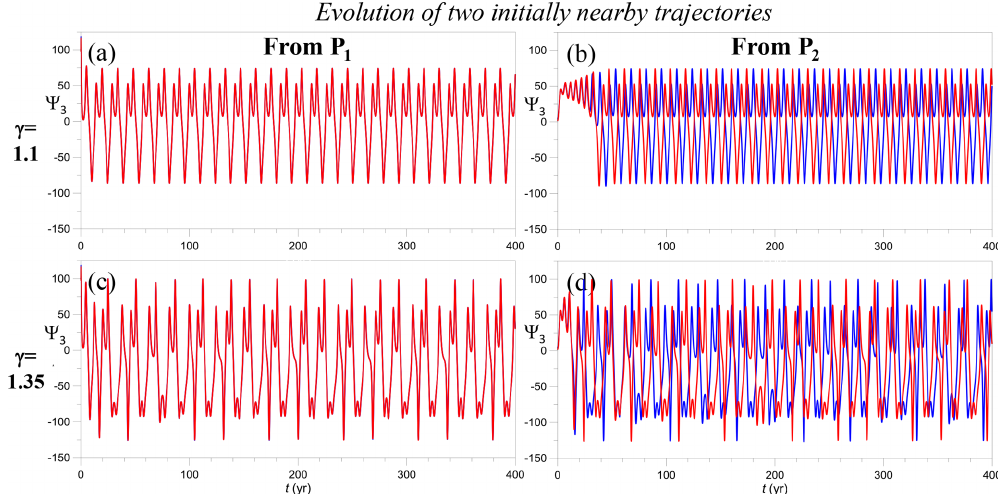
Figure 3. Typical behavior of time evolution of (cid:57) 3 (t) for different values of the parameter γ and different initial points in (cid:48) . (a) Two trajectories obtained for γ = 1 . 1 and initialized at P 1 (red line) and at a nearby point (blue line). (b) Same as in panel (a) , but for two trajectories starting from the point P 2 (red) and near it (blue). (c, d) Same as in panels (a) and (b) but for γ = 1 .